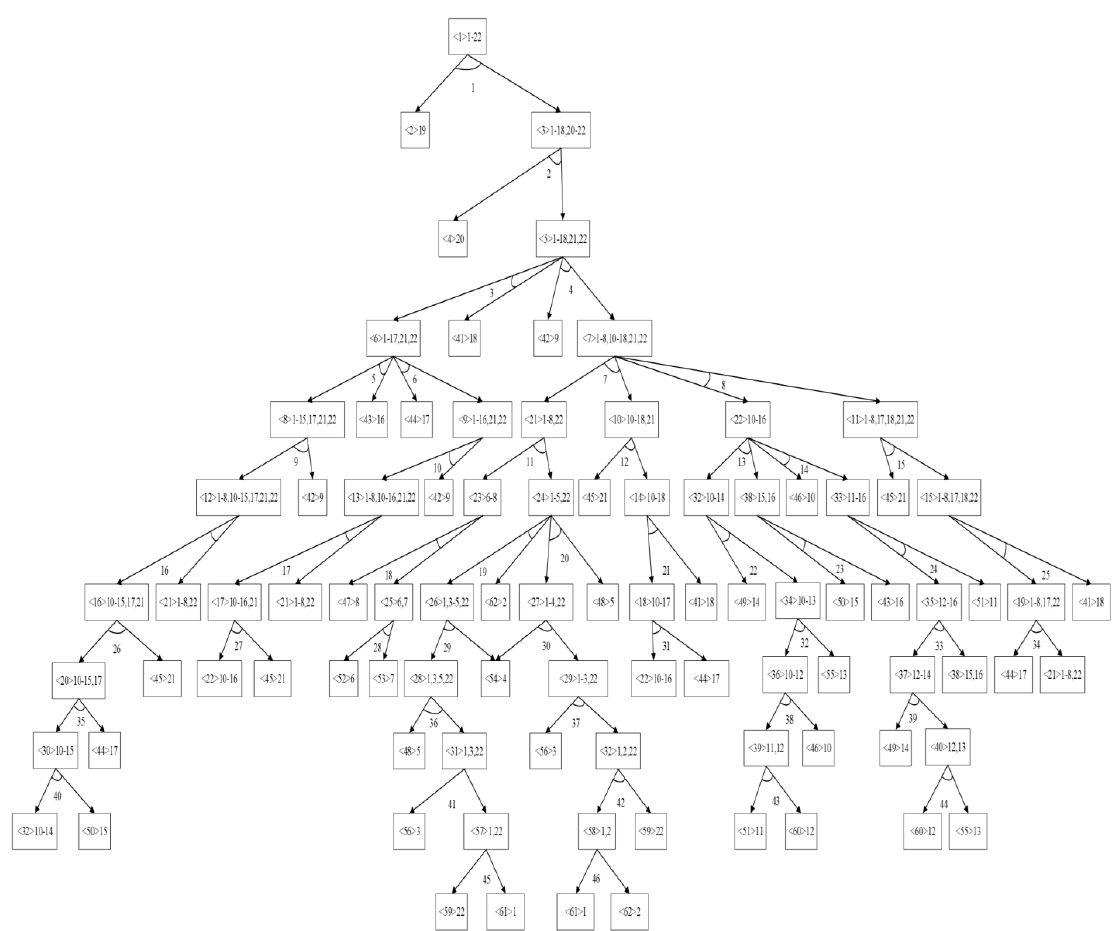
Figure A5. AND/OR graph of a hammer drill.